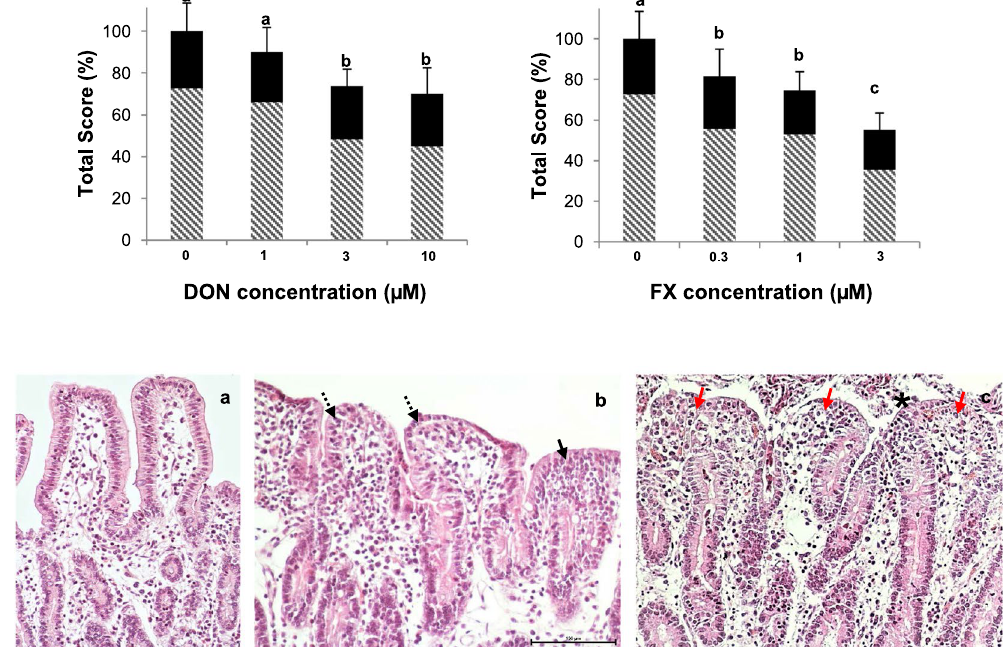
Figure 2. Effect of exposure of the jejunal explants to different levels of DON or FX. Top panel: Morphological scores (black) and lesional scores (striped) observed following the 4-hour exposure to DON or FX. The values are the mean percentage ± SD. a,b Mean values with different letters were significantly different (p < 0.05). Tukey test. Bottom panel: Histological aspects. ( a ) Control explant. Villi lined with columnar enterocytes (HE, 20x); ( b ) 3 µ M DON-exposed explant. Moderate fusion (black arrow) and villi showing cubic epithelial cells (dotted arrow) (HE, 20x); ( c ) 3 µ M FX-exposed explant. Villi showing severe apical necrosis (red arrow) and diffuse cellular debris ( * ) (HE,